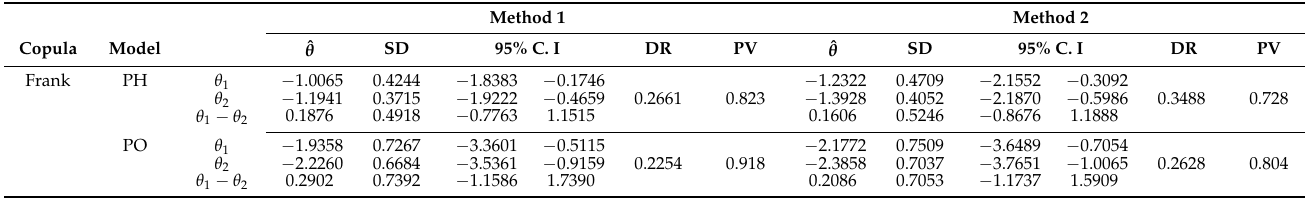
Table 10. The analysis for the AIDS